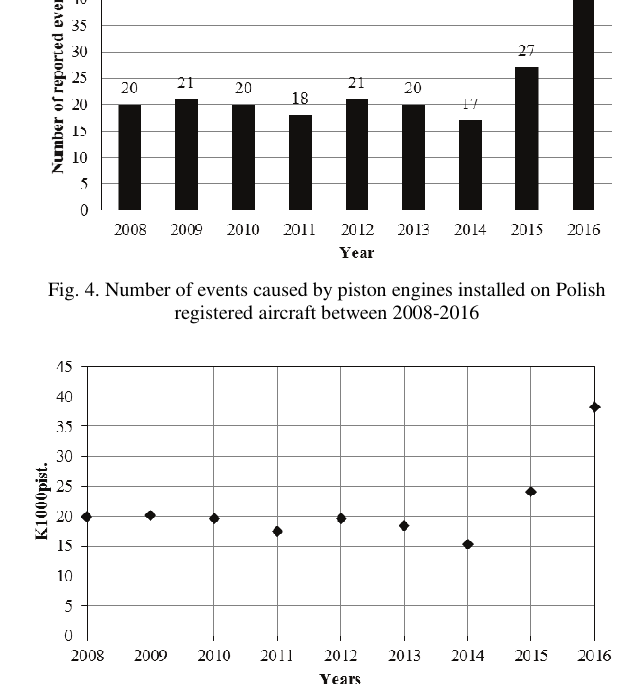
Fig. 5. Changes of the coefficient K